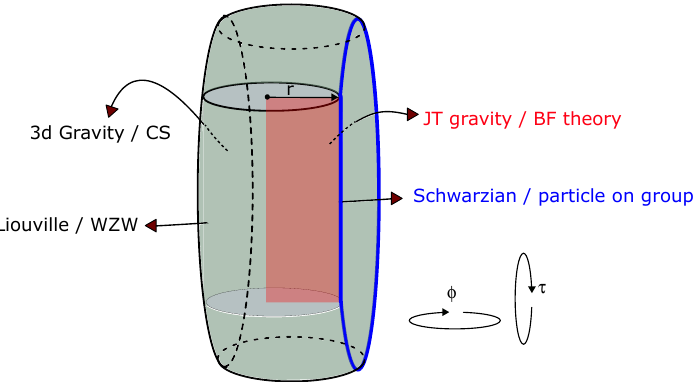
Figure 7 . Link between four theories through dimensional reduction, both for the gravity sector, as for the group theory sector. The interior of the torus is the 3d bulk. The torus itself is the holographic boundary. Reducing to the angular zero-mode gives a 2d bulk and a 1d boundary line.